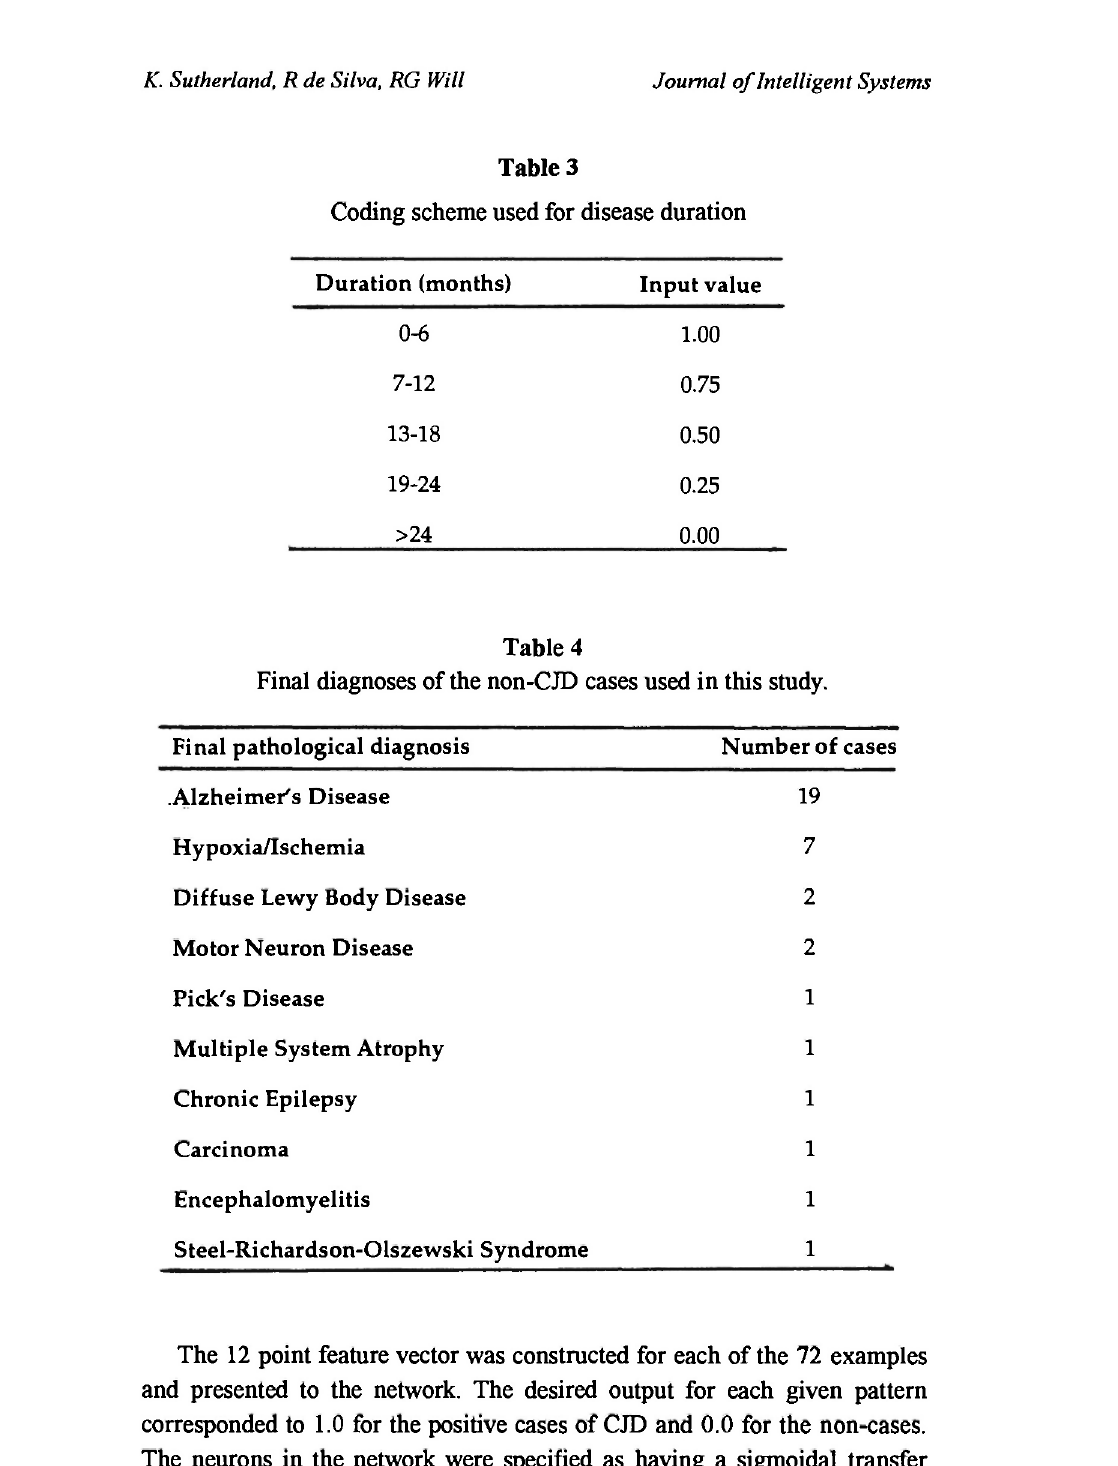
Coding scheme used for disease duration